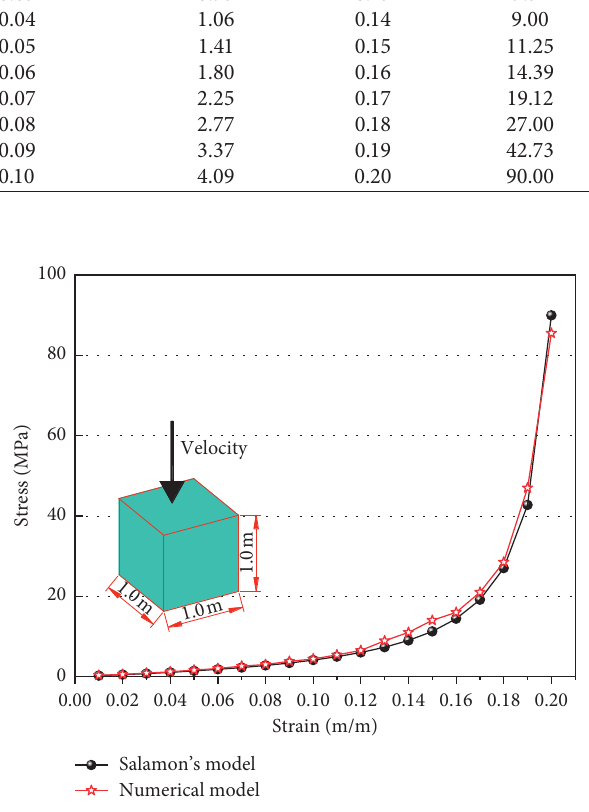
Figure 9: Comparison of the stress-strain curve between the numerical model and Salamon’s Figure 12. Coal pillars of different height ranges display varying displacement distribution characteristics. When the 15201 longwall face was 10 m inby, the horizontal displacement of the coal pillars at different heights was symmetrical across the width of the pillar. The horizontal displacement at different depths in the pillar varied between − 3.0, − 2.8, − 1.9, − 1.0, and 0 cm on the goaf side and between 2.7, 2.5, 2.3, 1.6, and 0.04 cm on the tailgate side. The zone of zero horizontal displacement was located at the core of the coal pillar ( x � 3.5 m) at different heights.